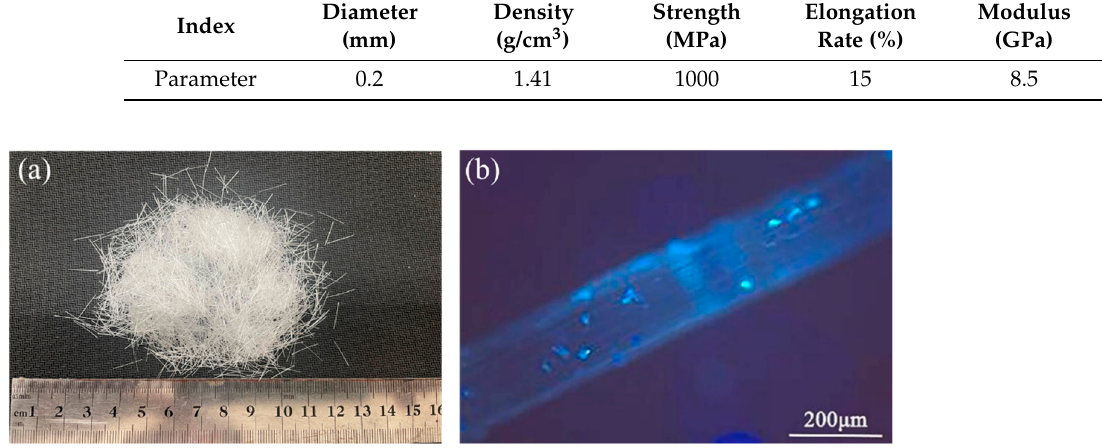
Table 4. Physical and mechanical properties of POM fiber.